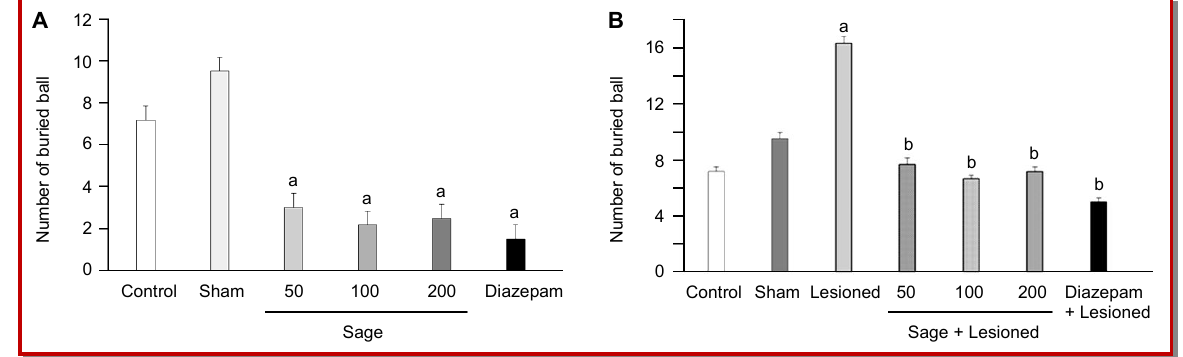
Figure 7: Effects of S. officinalis, methanolic extract (50, 100 and 200 mg/kg i.p.) or diazepam (1 mg/kg i.p.) in the presence or ab- sence of hippocampus lesion on marble-burying behaviour in rats during 30 min. Results are expressed as means ± S.E.M. (n = 6 per